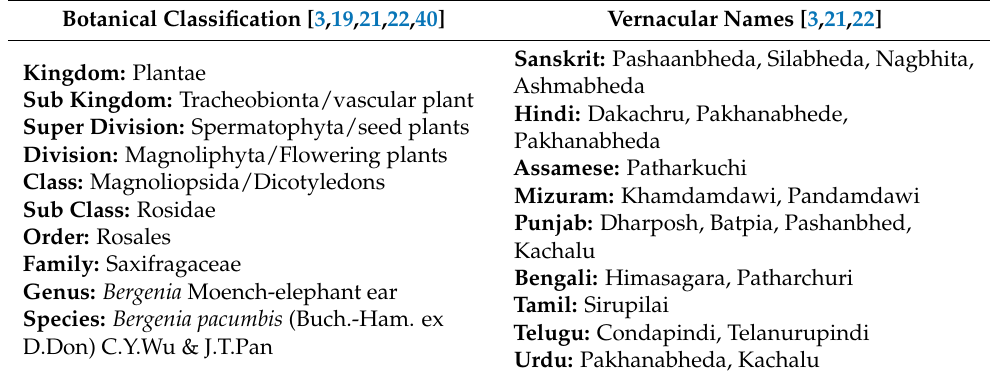
Table 1. Botanical and vernacular names of Bergenia pacumbis (Buch.-Ham. ex D.Don) C.Y.Wu & J.T.Pan. Botanical Classification